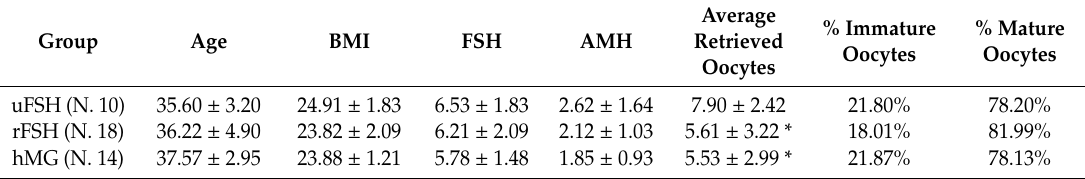
Table 1. Summary of patients’ data calculated within urinary FSH (uFSH), recombinant FSH (rFSH) and human Menopausal Gonadotropin (hMG) experimental groups: age; BMI (Body Mass Index), FSH (Follicle Stimulating Hormone) and AMH (Anti Müllerian Hormone) serum levels; number